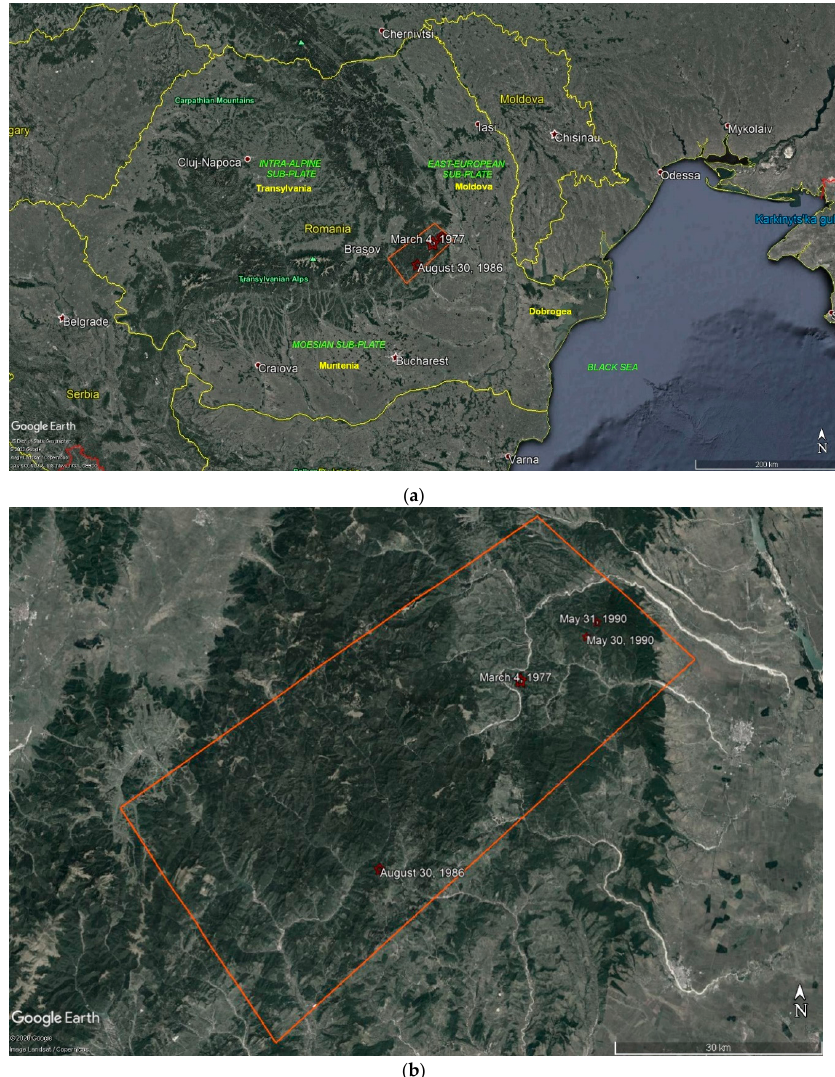
Figure 2. ( a ) Main tectonic structures in Romania, Google Earth 7.3.3.7699 45 ◦ 23 (cid:48) 37” N, 26 ◦ 26 (cid:48) 34” E, eye altitude 925 km, viewed 19 June 2020; ( b ) Localization of the major earthquakes recorded in Romania. Google Earth 7.3.3.7699 45 ◦ 40 (cid:48) 56” N, 26 ◦ 39 (cid:48) 33” E, eye altitude 124 km, viewed 19 June